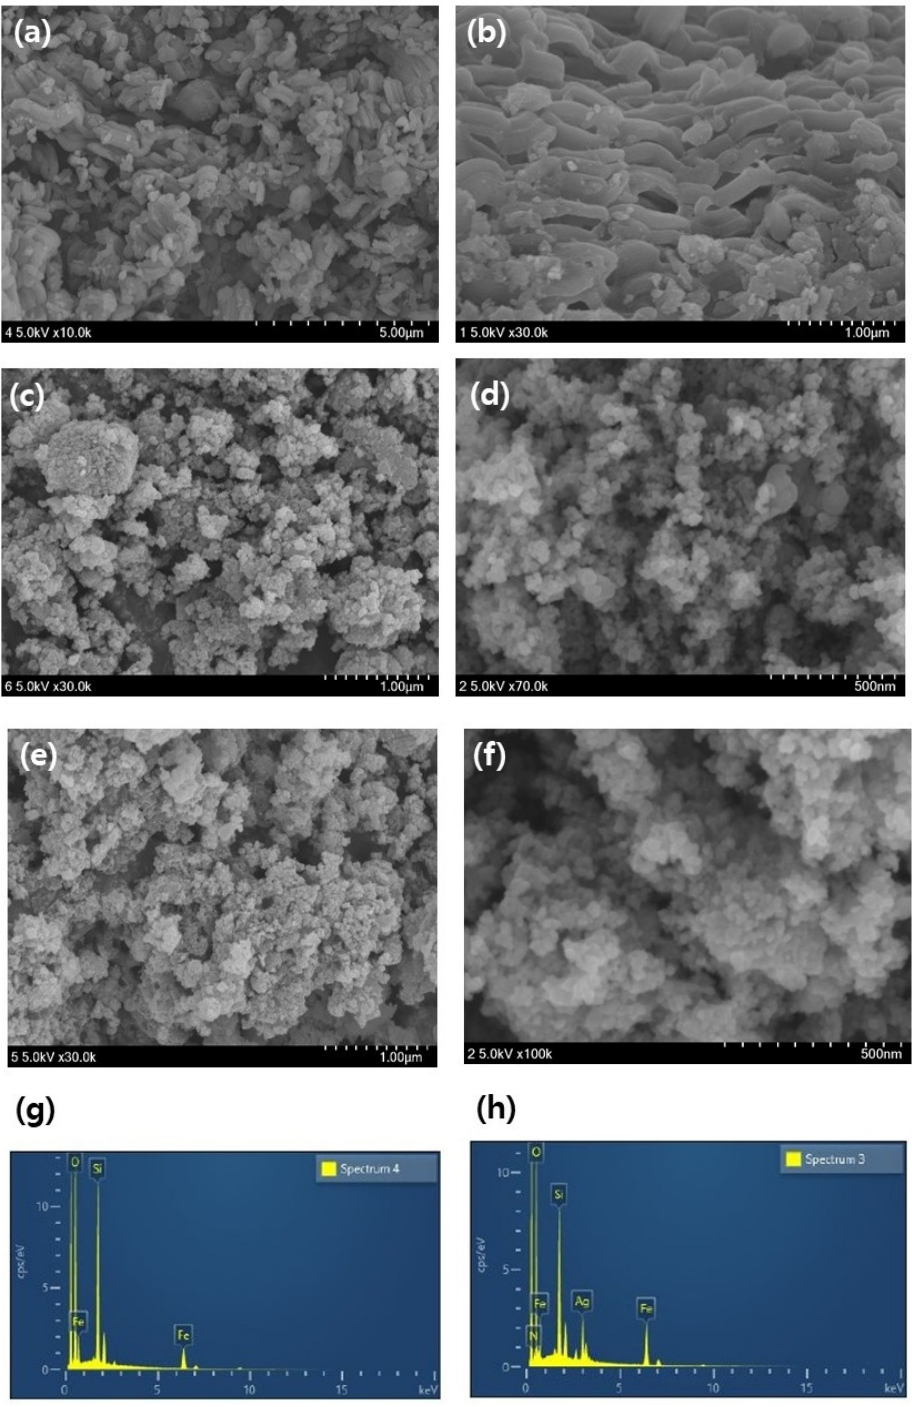
Figure 3. SEM image of ( a , b ) silica, ( c , d ) mag@silica, ( e , f ) mag@silica-Ag, and ( g , h ) EDS results of